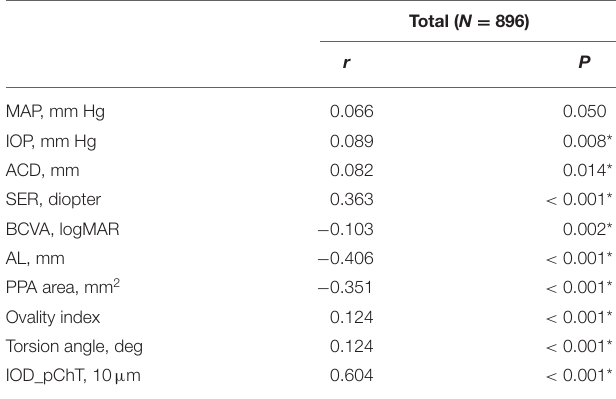
TABLE 3 | Partial correlation analysis between macular choroidal thickness and features of the optic disc adjusted for sex and age in all subjects.